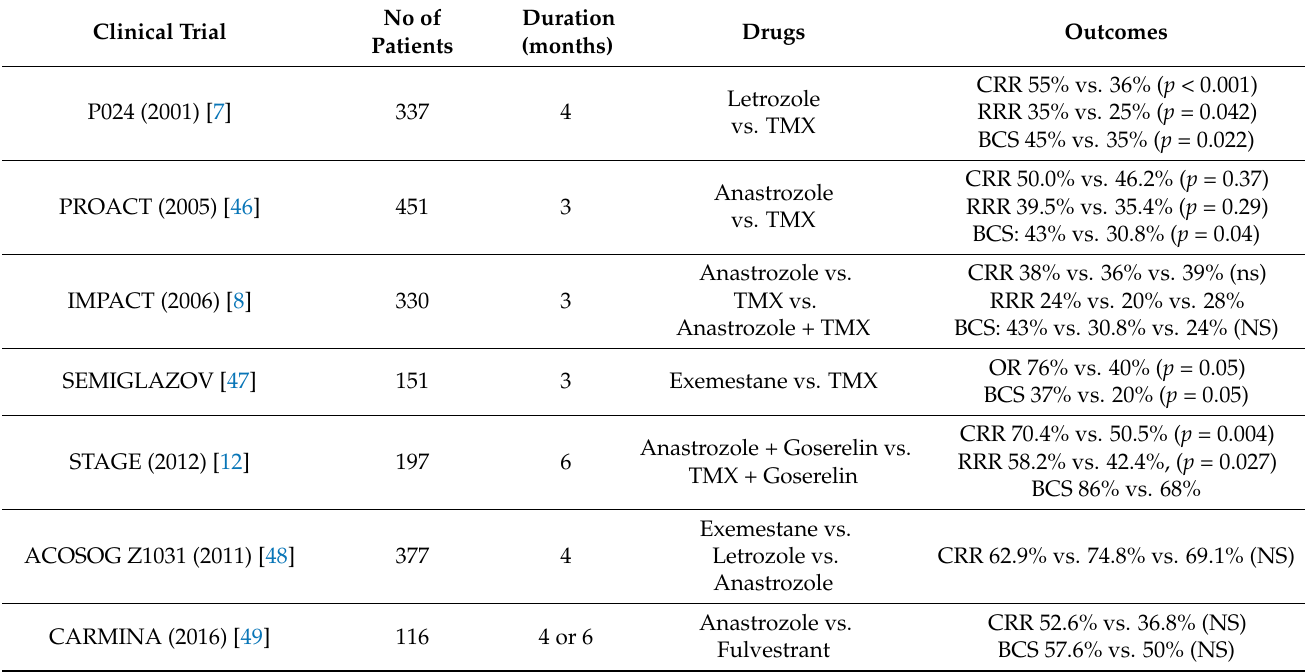
Table 2. Studies comparing tamoxifen vs. aromatase inhibitors vs. fulvestrant. Clinical